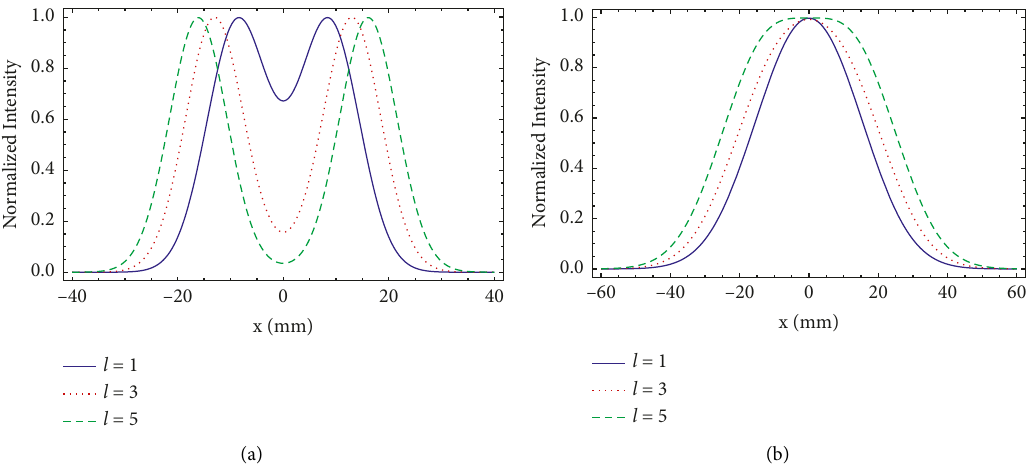
Figure 8: Cross-sections of the intensity distribution of the partially coherent circular flat-topped vortex hollow beam in anisotropic turbulent plasma for different values of the topological charge l at (a) z